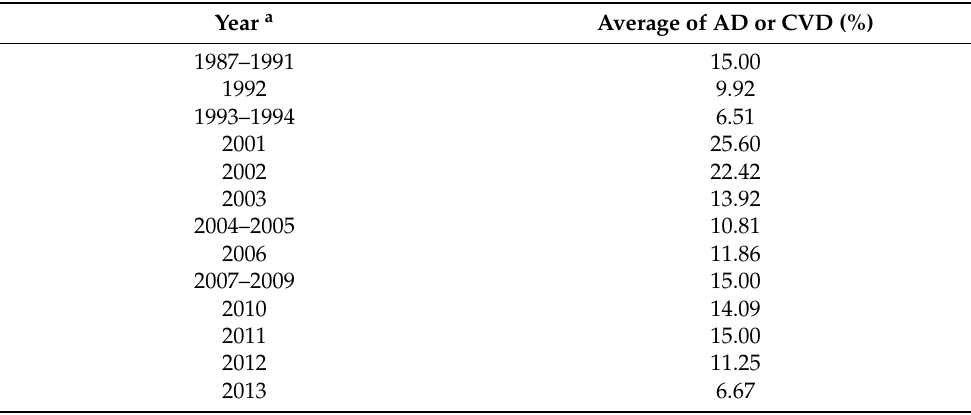
Table 1. Historical AD and CVD rates between Canada and the United